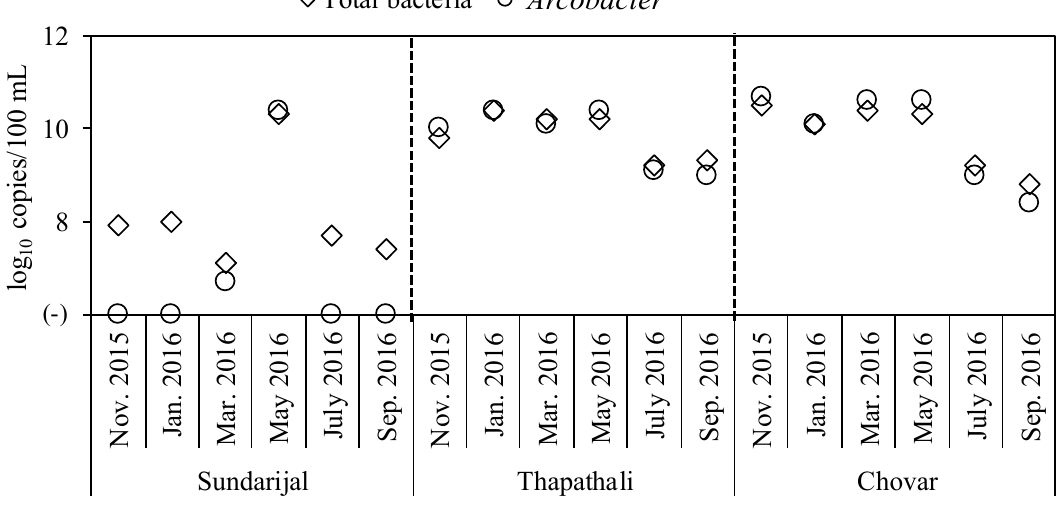
Figure 4. Concentrations of 16S rRNA genes of total bacteria and Arcobacter .